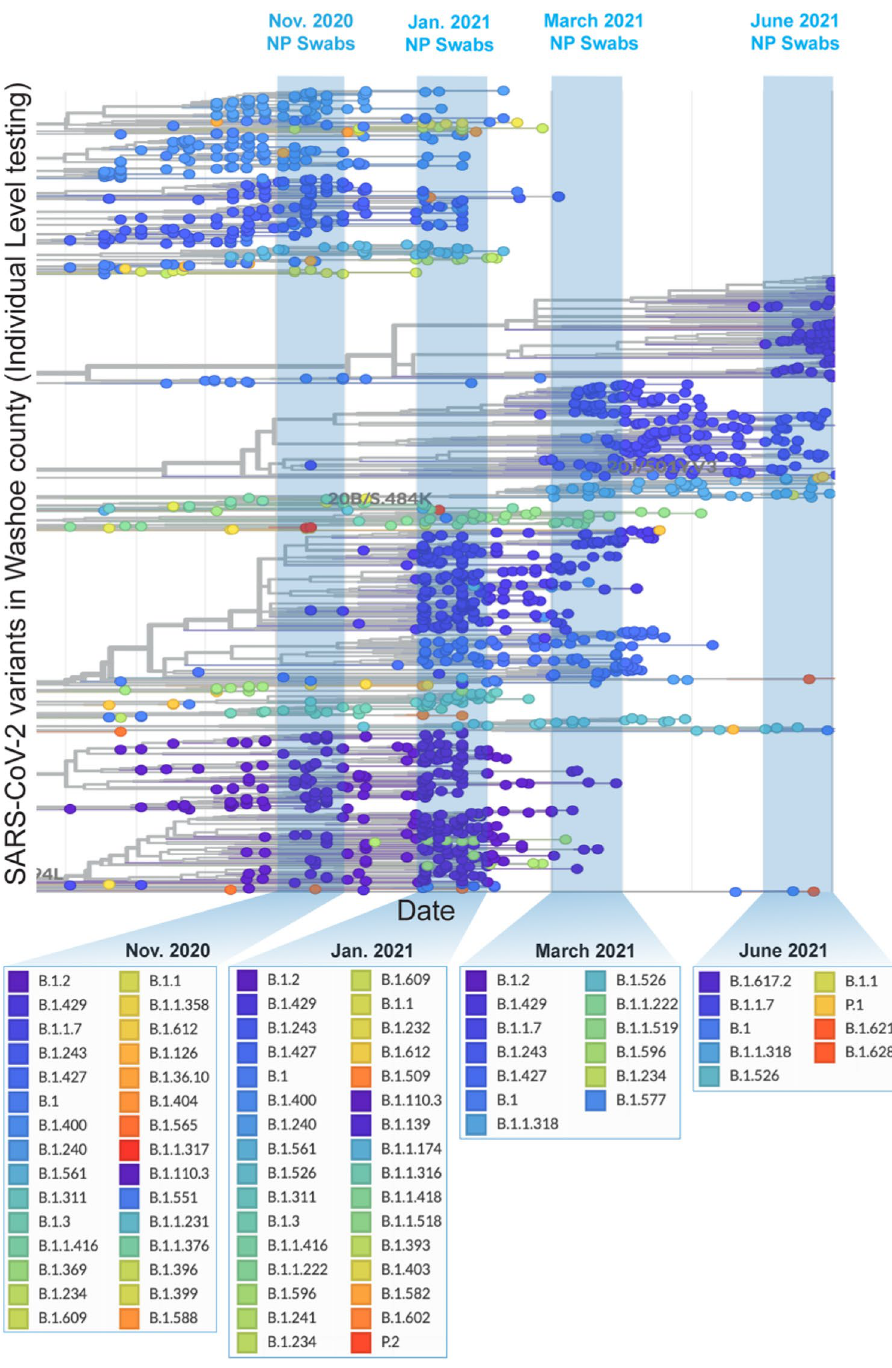
Figure 3. Circulated SARS-CoV-2 variants in the community (Washoe County, Nevada, USA) were plotted over time. SARS-CoV-2 variants sampled between July 1, 2020-June 30, 2021 were detected through sequencing of clinical specimens of COVID-19 patients. Blue bars represent the SARS-CoV-2 variants samples during the studied time periods, i.e., November 2020, January 2021, March 2021, and June 2021. Figure generated using NextStrain 20